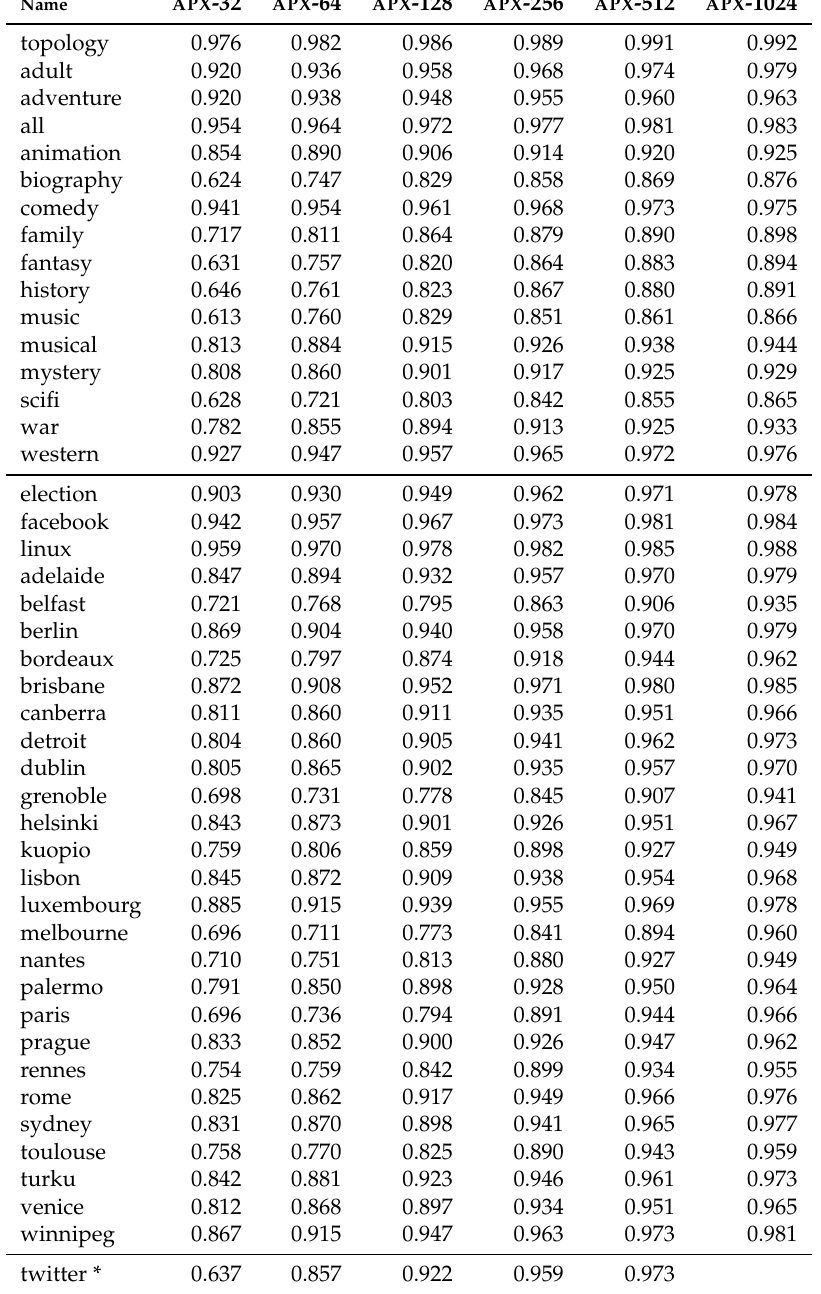
Table A3. Average Kendall’s τ values for the graphs in our dataset: the Kendall’s τ is computed by referring to the ranking computed by EXACT , (the cell marked with * is an estimation) apart from the twitter graph, where we refer to the ranking computed by APX